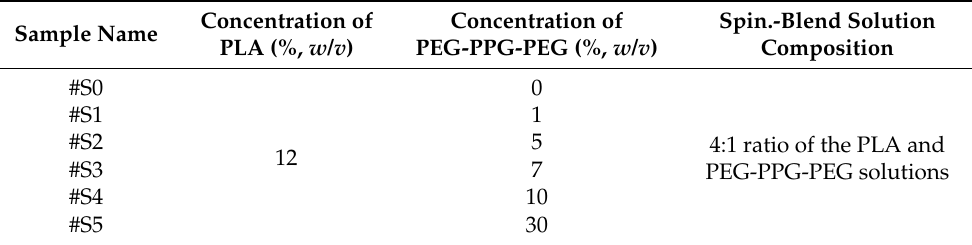
Table 1. Labels and compositions of the PLA and PLA/PEG-PPG-PEG